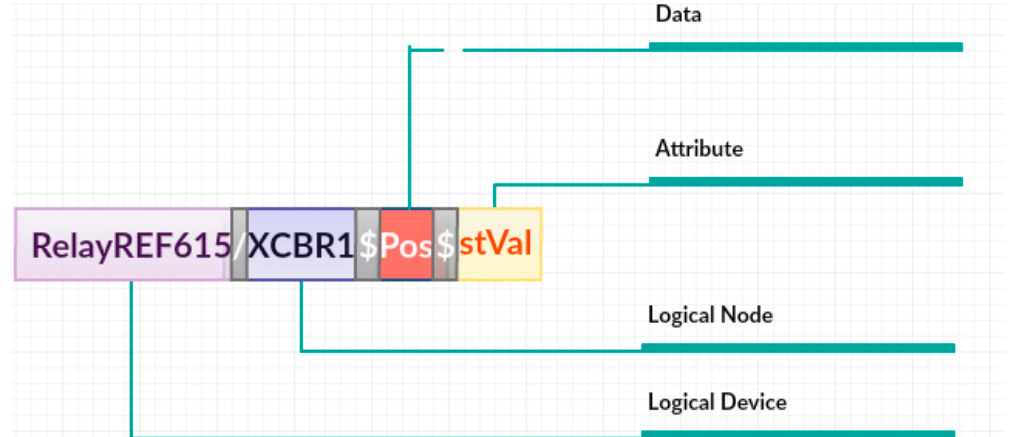
Figure 2. IEC 61850 Object Name Structure.